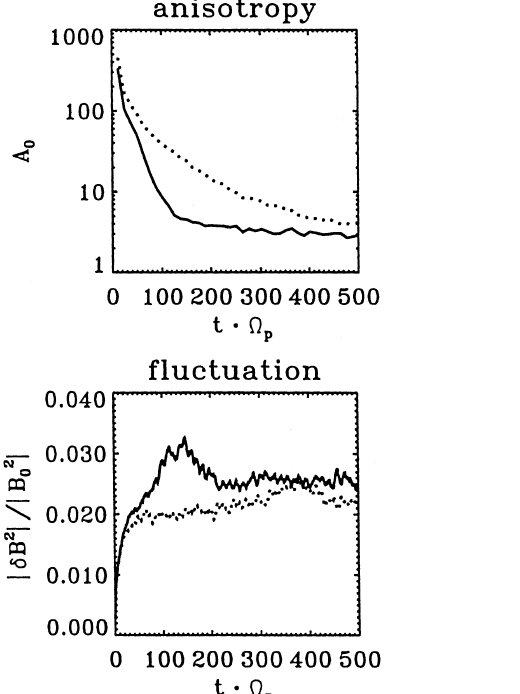
Fig. 8. Evolution of anisotropy and magnetic fluctuation level for two nongyrotropic particle densities; the solid lines represent n 0 (cid:136) 0 : 02 n p ; the dotted lines represent n 0 (cid:136) 0 : 01 n